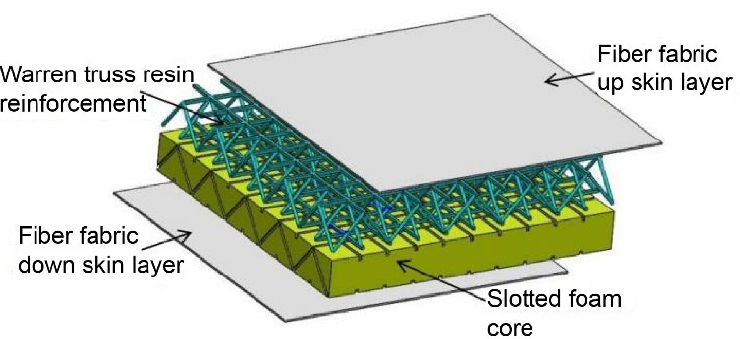
Figure 9. Diagram of the lattice cell Warren truss slot resin-reinforced foam sandwich structure.